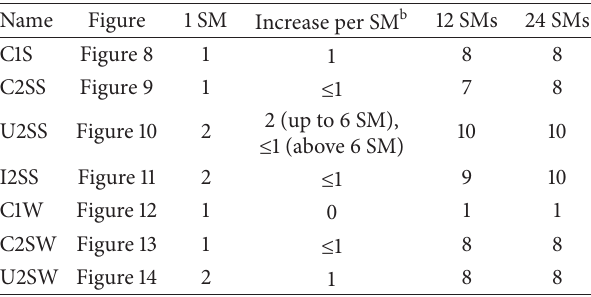
Table 2: Summary of eigenspectra results a